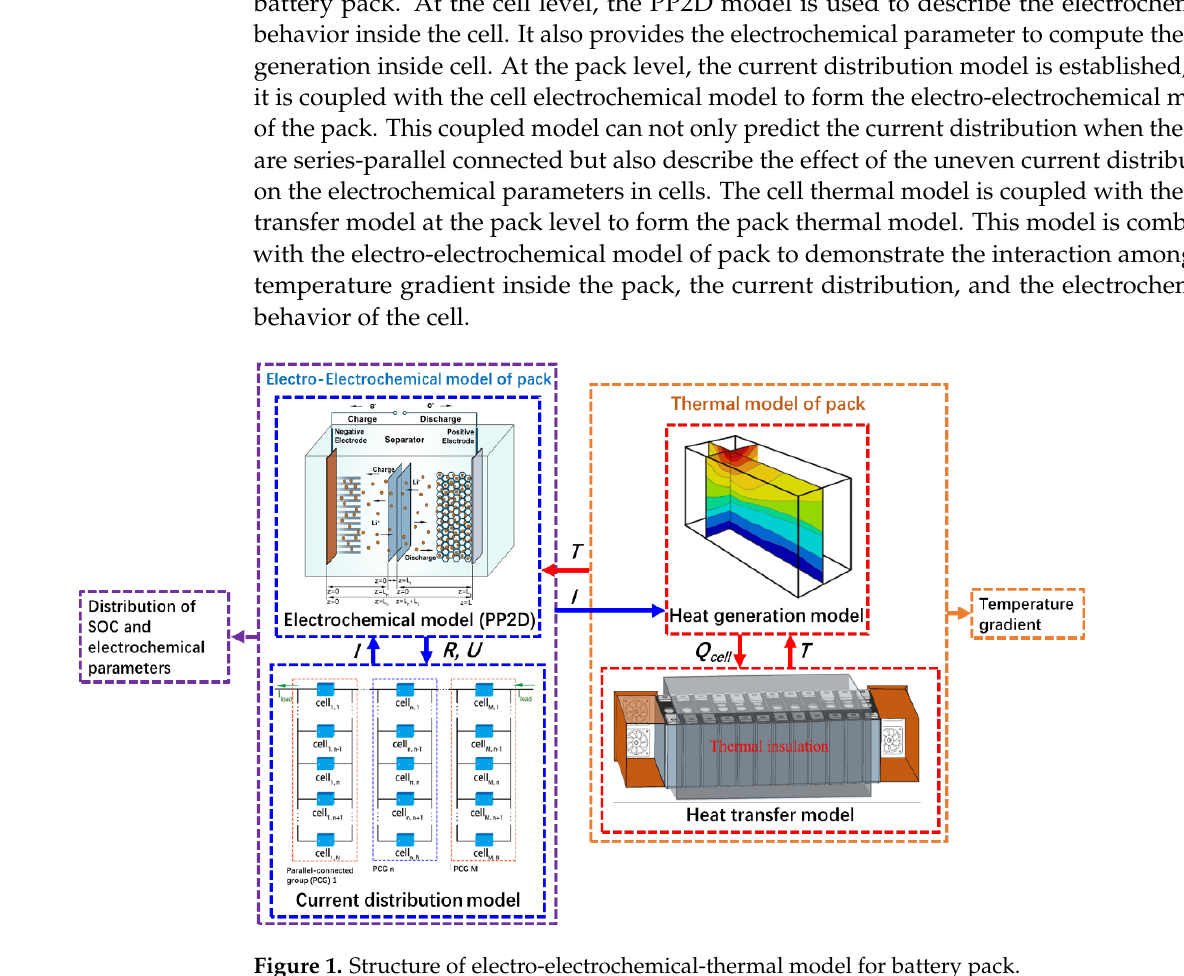
Table 1. Structure of P2D model.